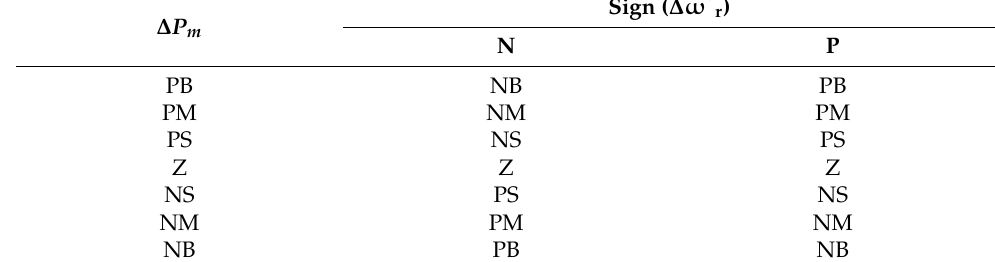
Figure 4. Block diagram of the fuzzy logic (FL)-based WT MPPT algorithm.